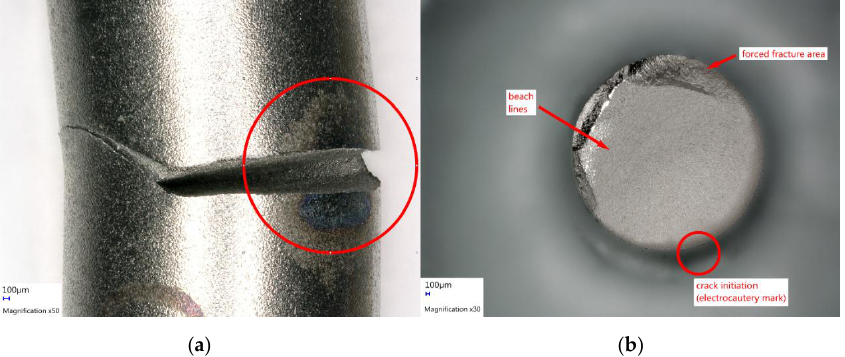
Figure 6. Microscopic analysis of fractured titanium rod after electrocautery (VHX-5000, Keyence, Osaka, Japan). ( a ) Post-fracture situation at the electrocautery mark. ( b ) Fracture surface with typical signs of fatigue fracture (beach lines and forced fracture area). The circle shows the location of crack initiation at the electrocautery mark.